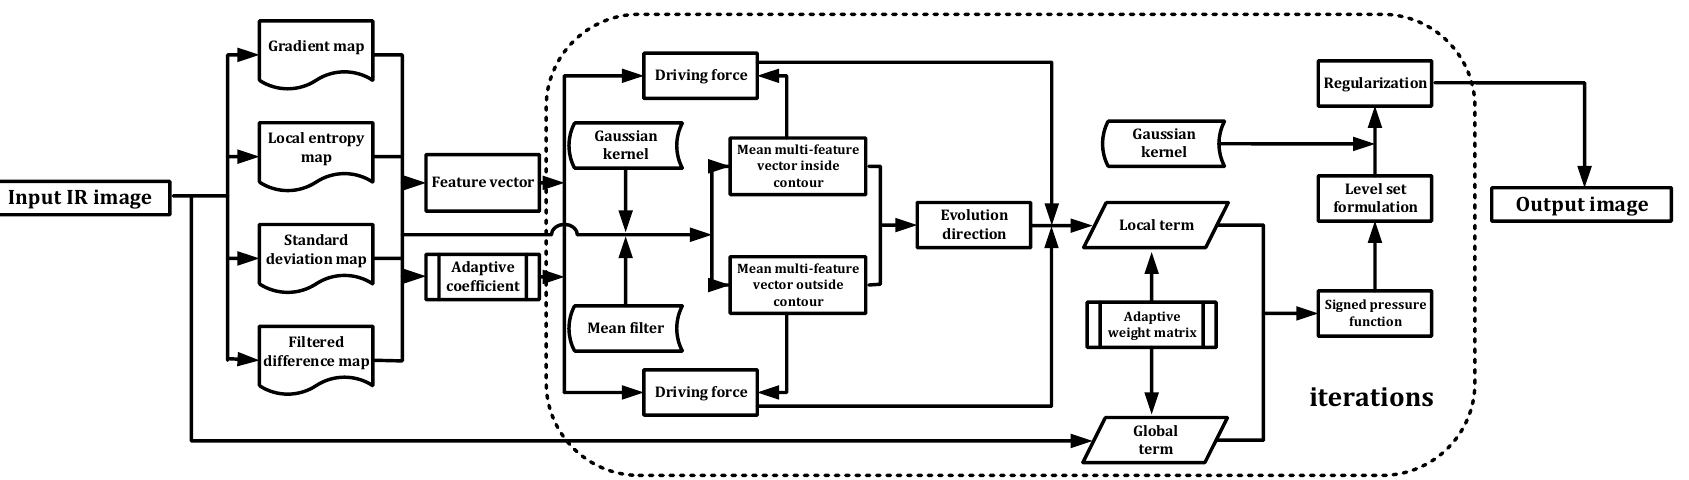
Figure 1. Flow chart of the proposed method (IR is the acronym of infrared).